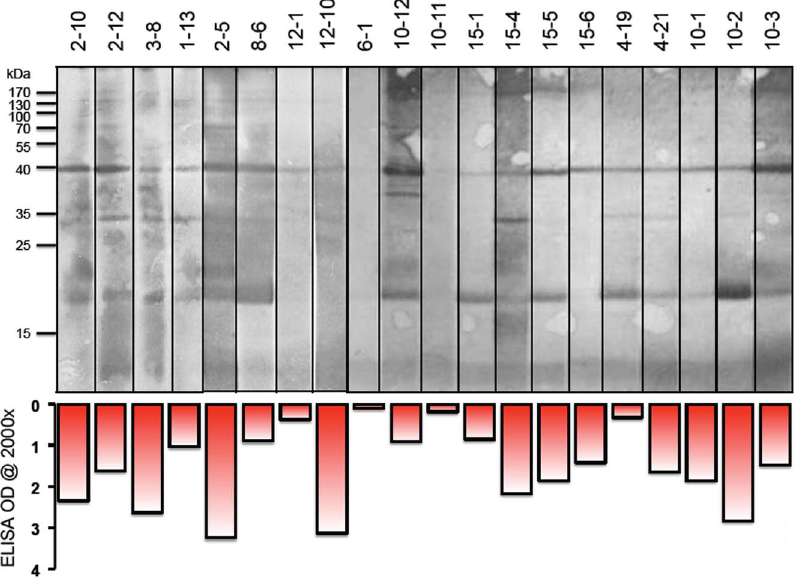
Figure 5. Western blot analysis. Orf virus antigens were probed with different sera from 9 farms with different antibodies titers. doi:10.1371/journal.pone.0066958.g005 PLOS ONE |